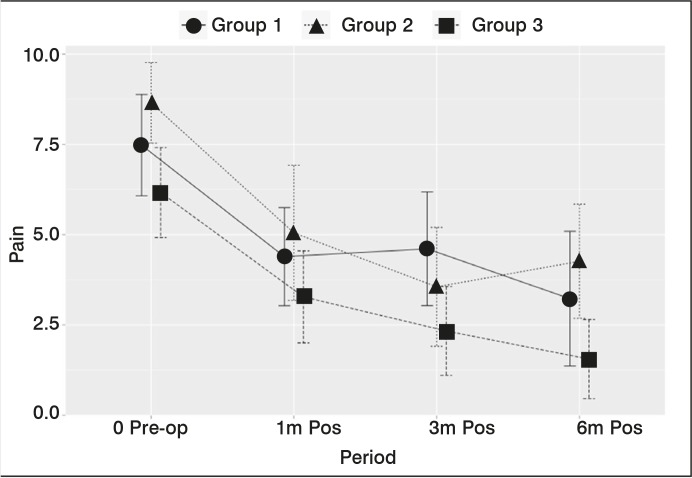
VAS: group x period.